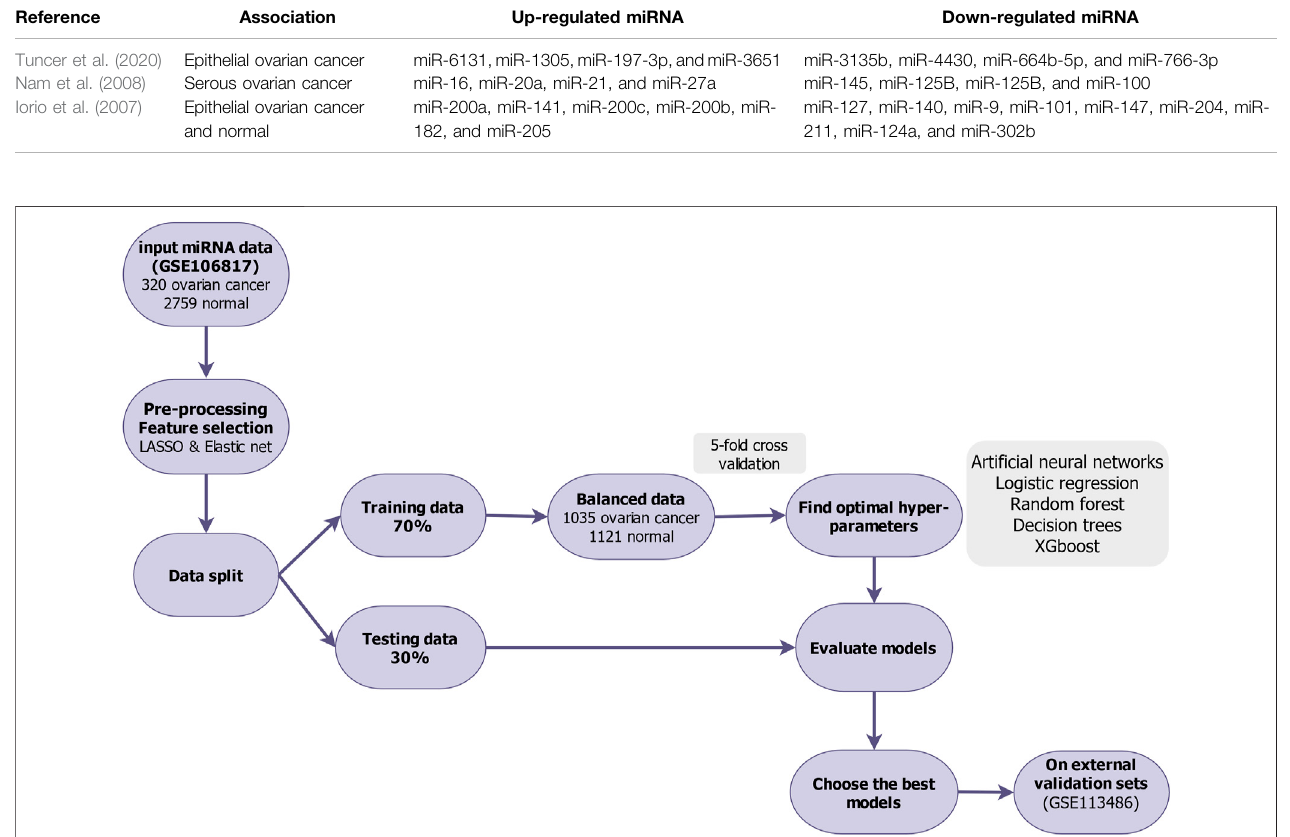
TABLE 1 | Summary of miRNA genes shown to be statistically signi fi cantly associated with ovarian cancer.